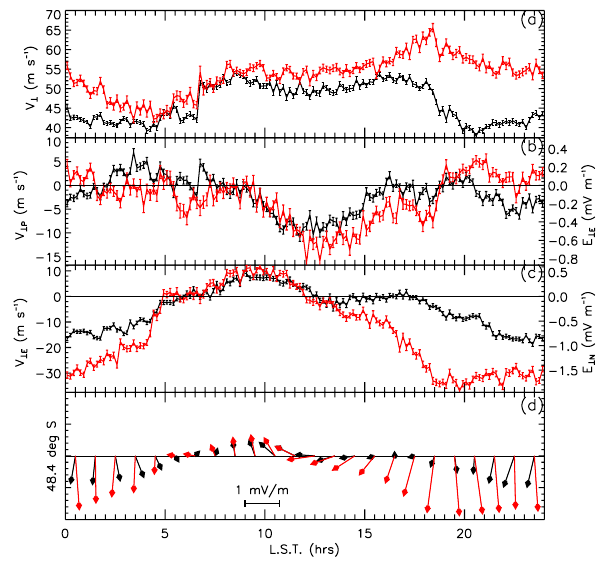
Fig. 3. Diurnal patterns of F-region drift and equivalent electric field during geomagnetically quiet conditions (AE < 75nT) (black) and very disturbed conditions (AE > 500nT) (red) for (a) the veloc- ity magnitudes, V ⊥ , (b) the field-perpendicular motion in the pole- ward direction, V ⊥ P , and (c) the field-perpendicular motion in the eastward direction, V ⊥ E . (d) Feather plot of the equivalent field- perpendicular electric field vectors where the poleward direction is downward and the eastward direction is to the right.